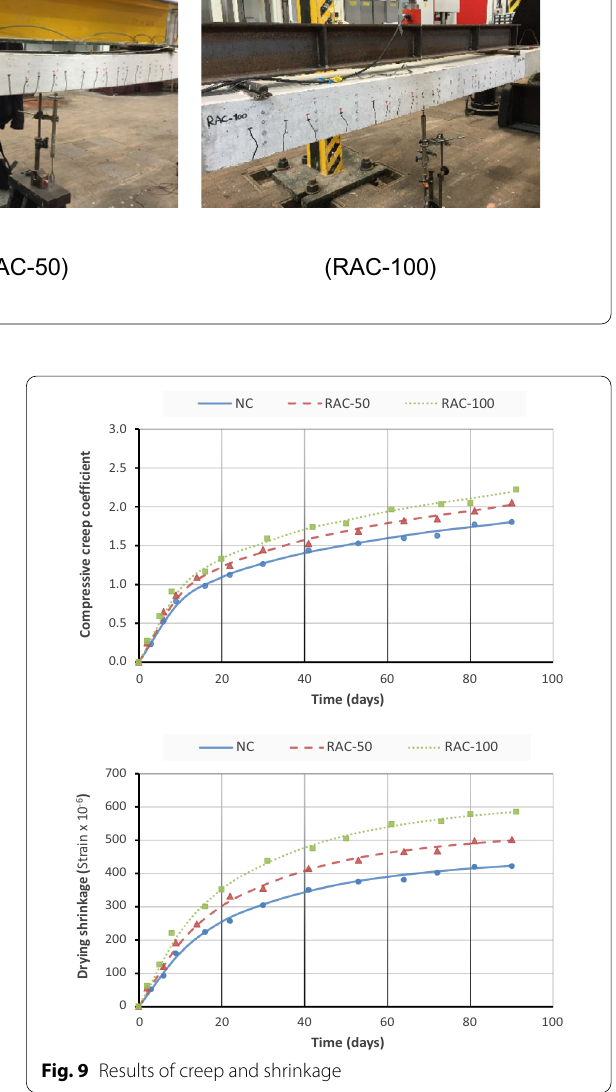
Fig. 9 Results of creep and